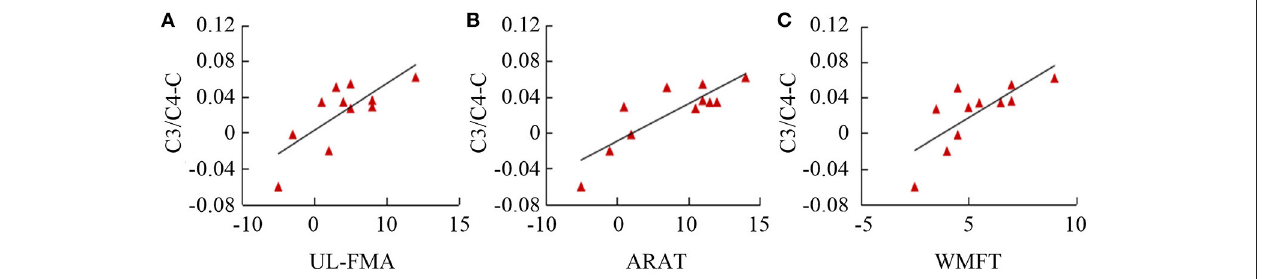
tested the effects of training. Both the WMFT and ARAT demonstrated significant improvement in upper limb motor function after training. These findings indicate that the novel training system improved motor function of the upper